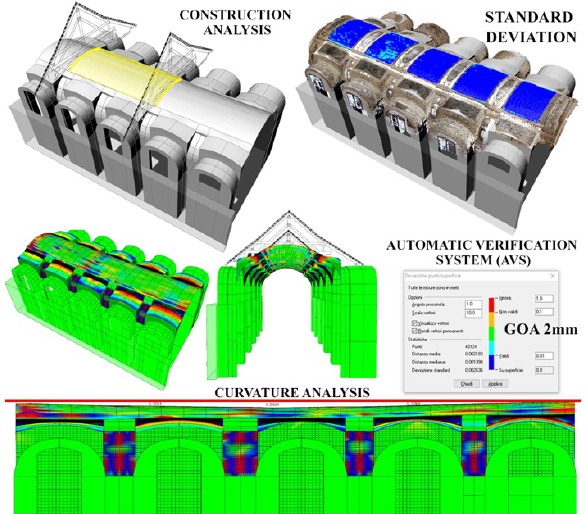
Figure 11. Automatic Verification System of the vault of the Italian Cultural